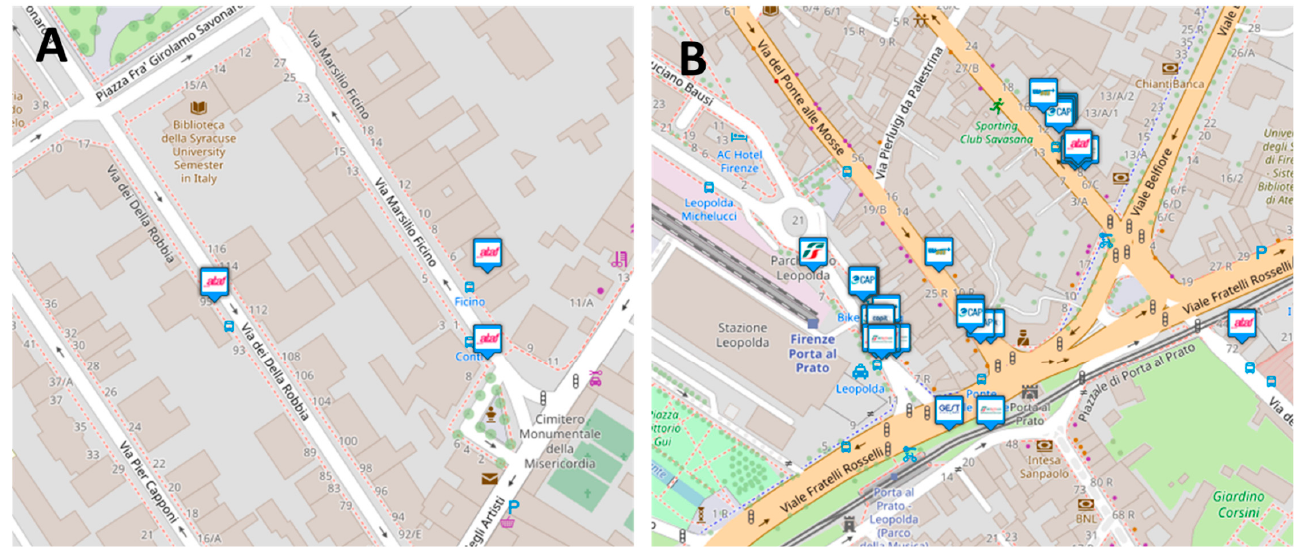
Figure 5. Density of stops near two sample stops 𝐀 and 𝐁 .